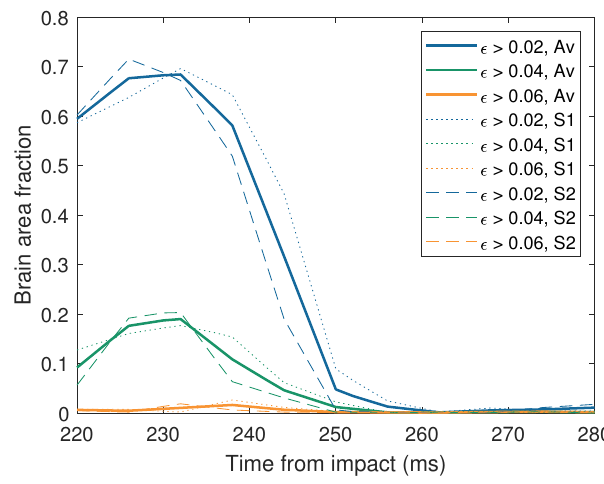
Figure 7. Examples of brain deformation measures adapted from Sabet et al. [53]. ( a ) Colourplots indicating the brain deformation levels from the point of impact (216 ms from trigger release) as radial-circumferential strain for subject S1 and S2, adapted from [53]. Again the authors have presented additional data depicting the average response between the subjects, calculated by digitising the published contour plots into strain levels for each subject, averaging them at each pixel and re-plotting into a new contour plot on the same scale as the original image. Only pixels where both subjects have brain tissue (contour plot is coloured) are included in the average. The slice shown is in the axial plane, 2 mm above the plane between genu and splenium of the corpus callosum. ( b ) Area fraction of the brain experiencing radial-circumferential strains above thresholds of 0.02, 0.04 and 0.06 in the axial plane, 2 mm above the plane between genu and splenium of the corpus callosum. The levels experienced by S1 and S2 [53] are presented, again with additional data showing the mean between the cases, indicated as “Av”, calculated by the authors for the purposes of this